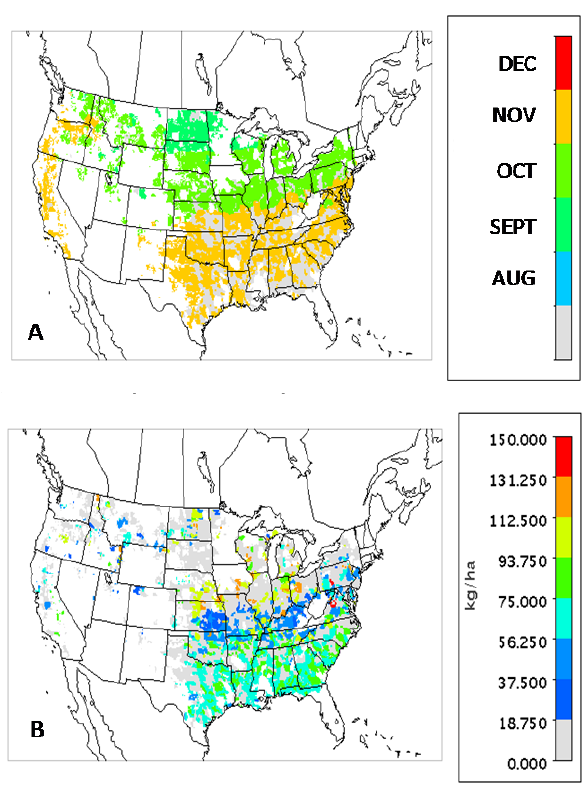
Fig. 3. EPIC simulated winter wheat (A) date of first fertilizer ap- plication and (B) rate applied on that date across the continental